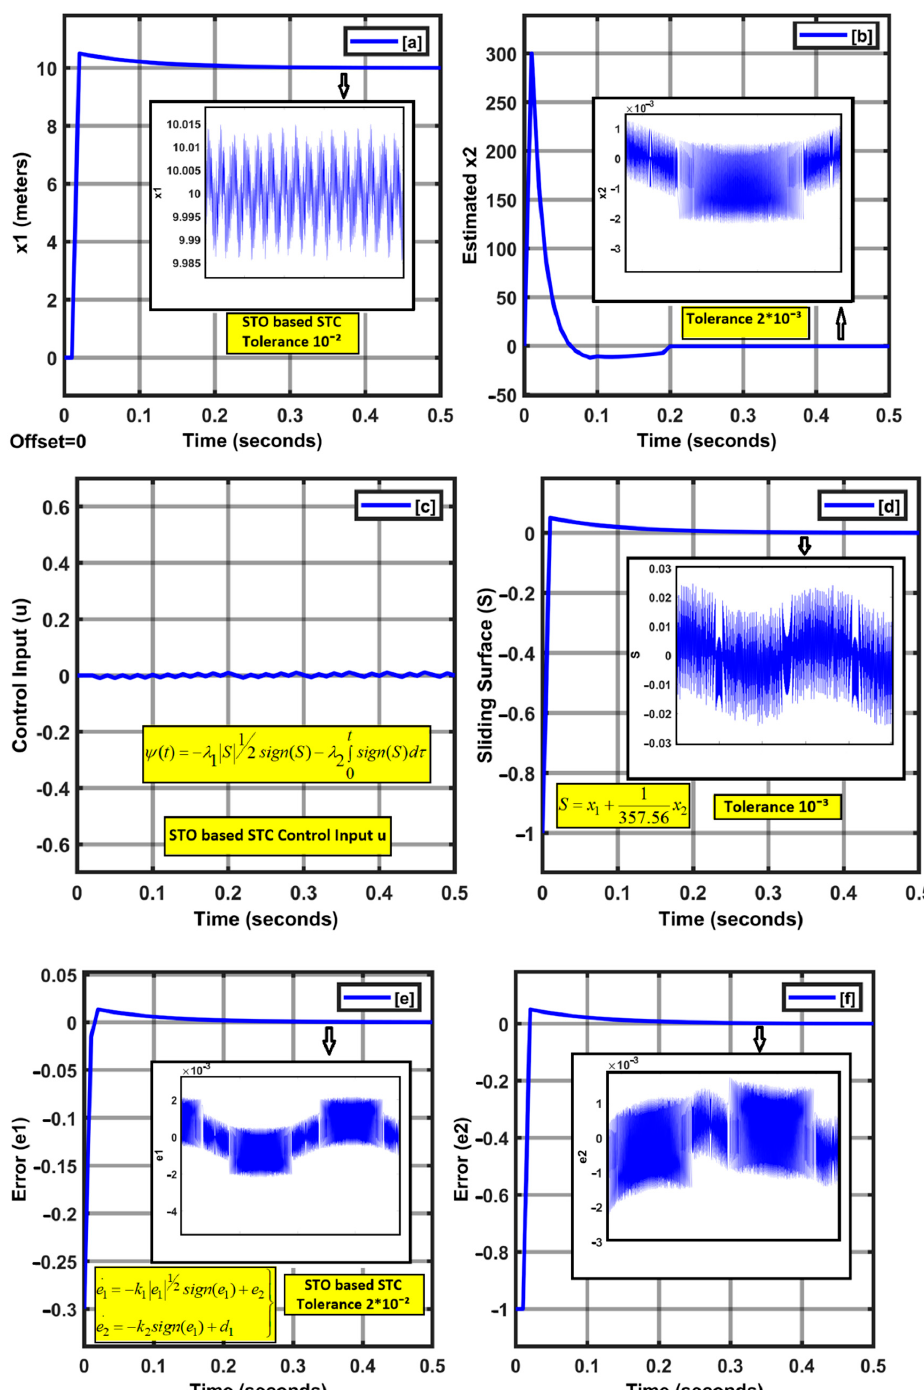
a good precision of 10 − 3 .